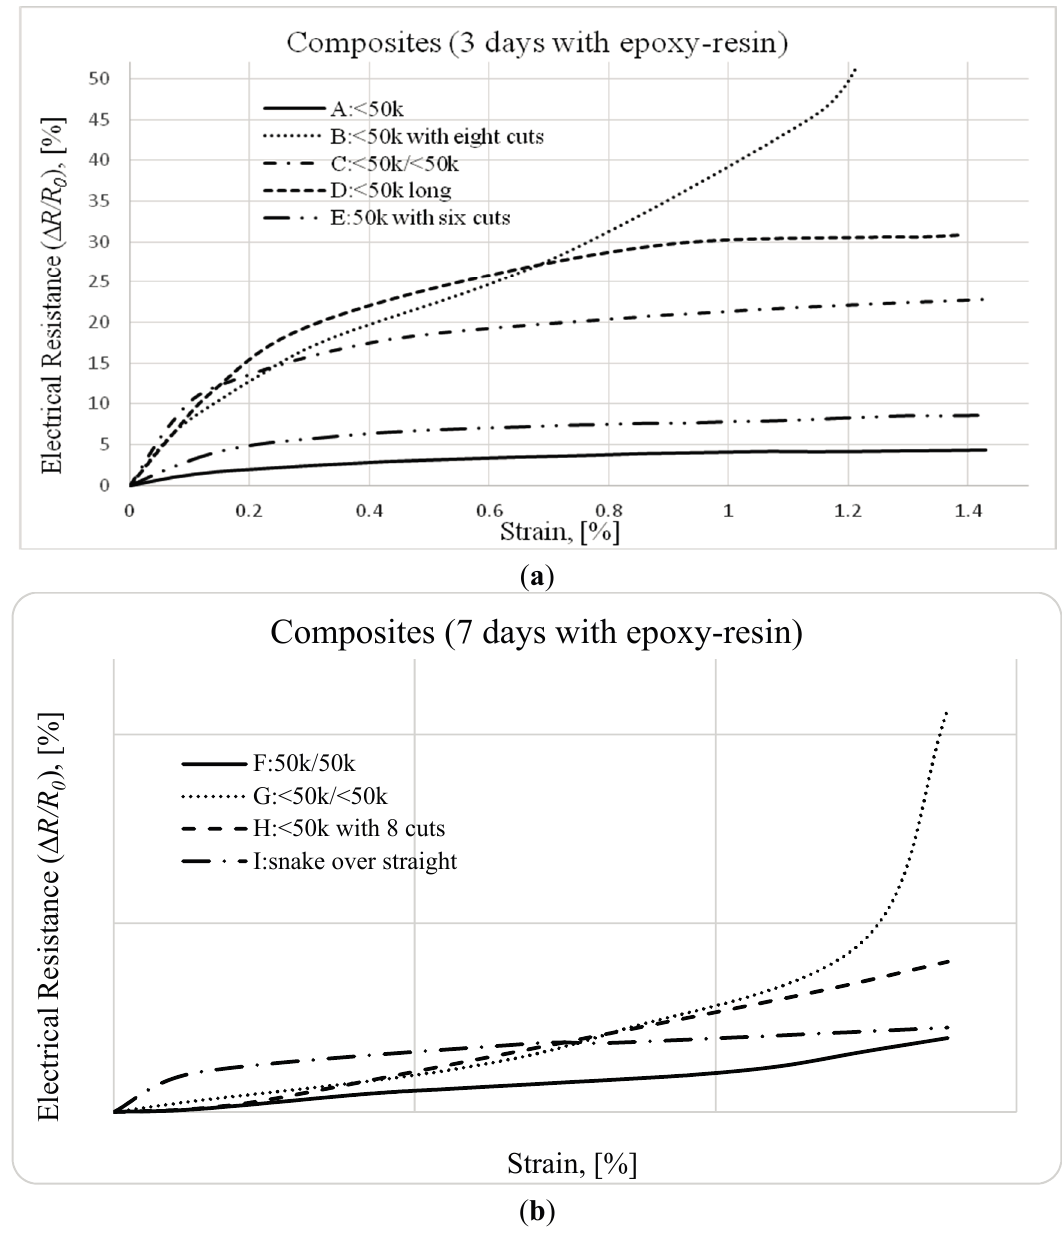
Figure 6. The relative electrical resistance versus strain of Continuous Carbon Fibers Epoxy Composites: ( a ) 3 days cure and ( b ) 7 days